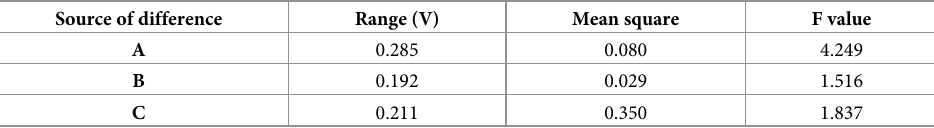
Table 3. Data analysis results for optimal parameters for canine-mimicking nasal cavity.